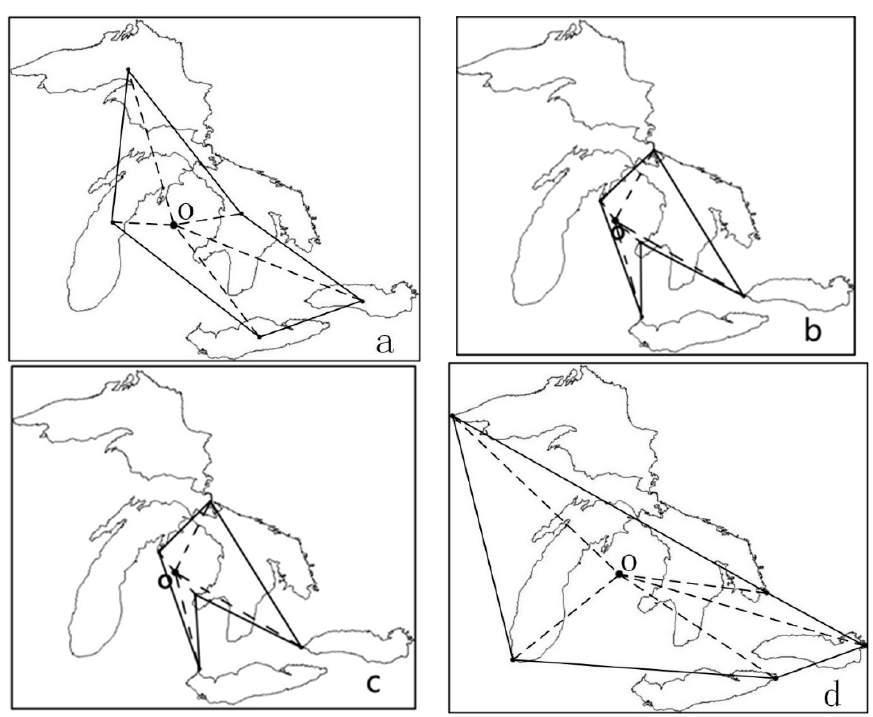
Figure 12. Position graphs of the Great Lakes in 1986. ( a ) CPPG in 1986; ( b ) NTPPG in 1986; ( c ) NPPG in 1986; and ( d ) FPPG in 1986.